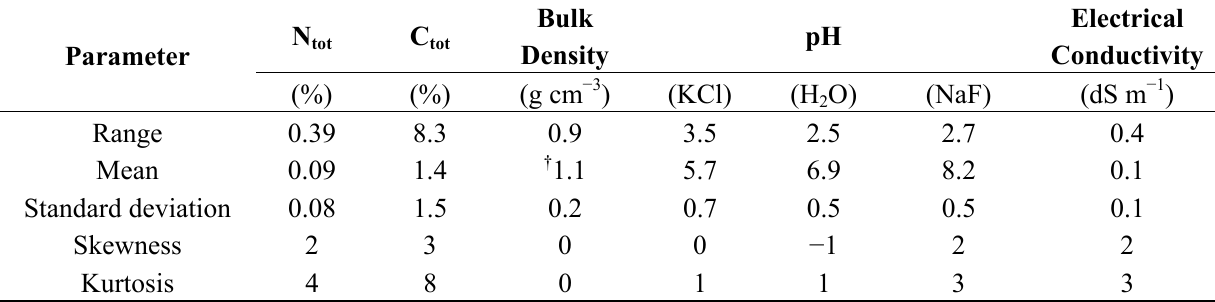
Table 1. Reference laboratory data statistics for the samples used in this study (N =